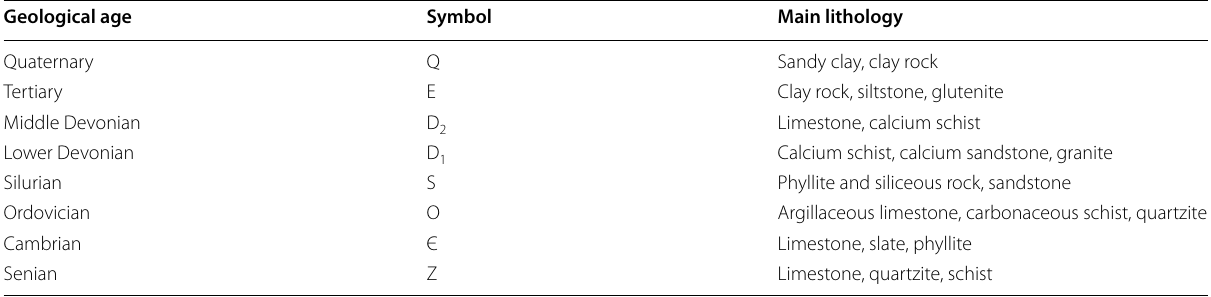
Table 1 The main lithology information of the study area Geological